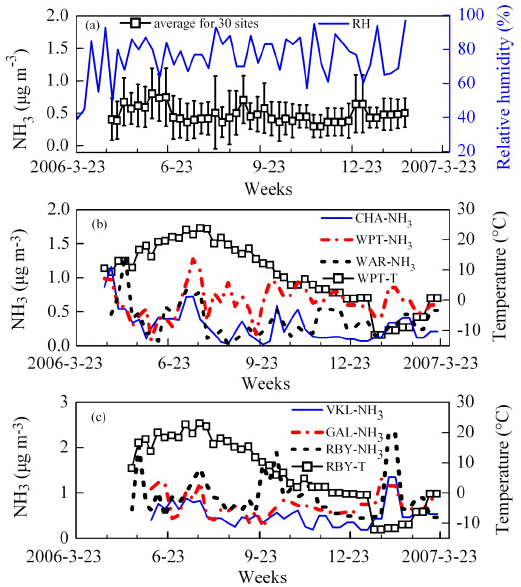
Fig. 5. Temporal variations of NH 3 in 2006–2007 at sites located in the low concentration zones: (a) the spatially averaged value over 30 sites, (b) three sites having data before June, and (c) three sites having no data before June.